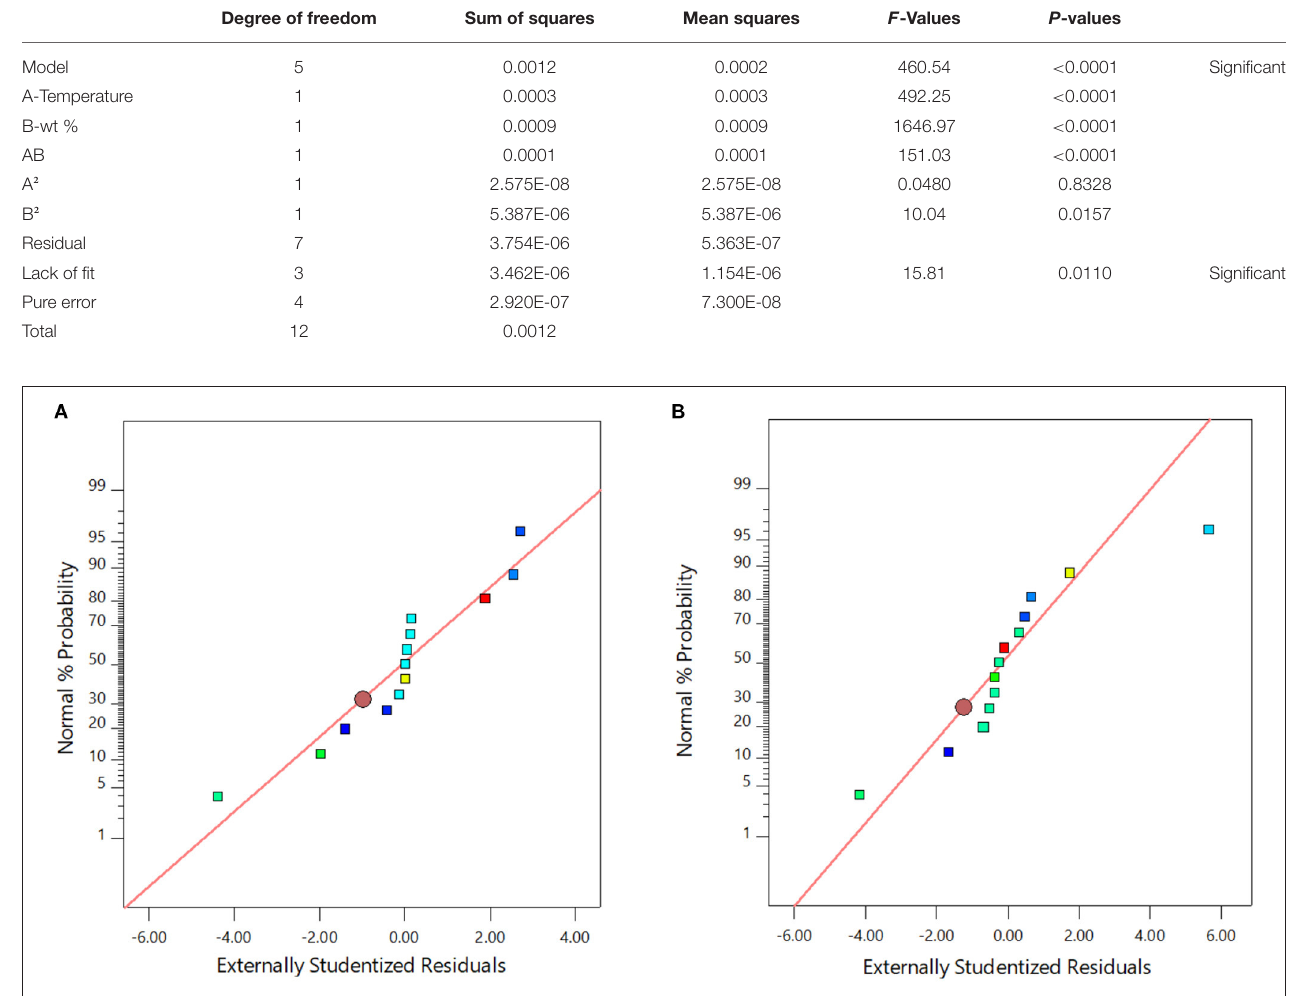
Frontiers in Mechanical Engineering |